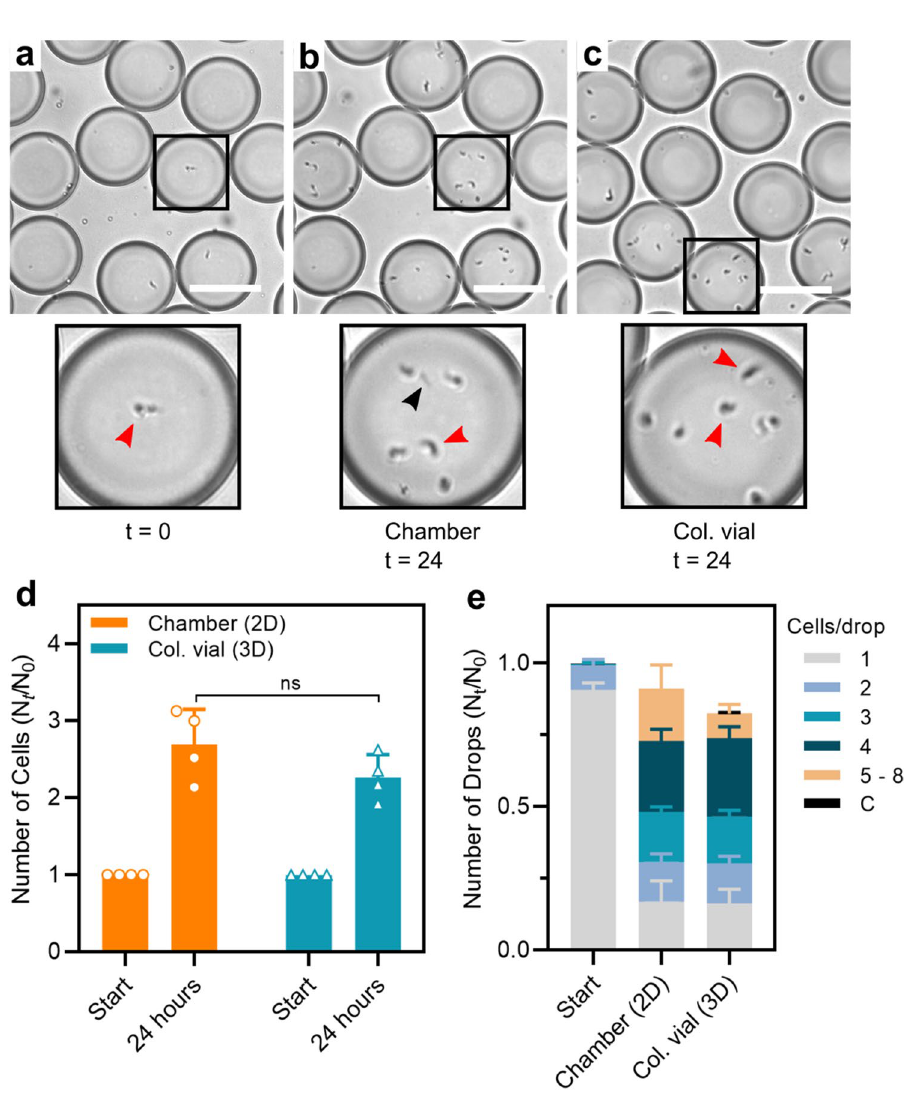
Figure 5. Collection and incubation of 0.5 nL drops in chamber vs. collection vial. ( a ) Snapshots of encapsulated T.b. brucei cells at beginning of incubation, ( b ) after 24 h of incubation in chamber and ( c ) after 24 h of incubation in collection vial, visualized through a x10 microscopic objective. Micrographs display close-up examples of encapsulated trypanosomes in drops of the respective collection devices. ( d ) Comparison of cell survival as normalized values after collection and 24 h of incubation in incubation chamber and collection vial. ( e ) Supporting cell survival data is the presentations of growth after 24 h as normalized number of drops containing a given number of cells in the different collection devices. All data are presented as mean values ±SD made as biological replicates (n = 4). Two-sided Student’s t test were used to find significance value ( P = 0.16) in ( d